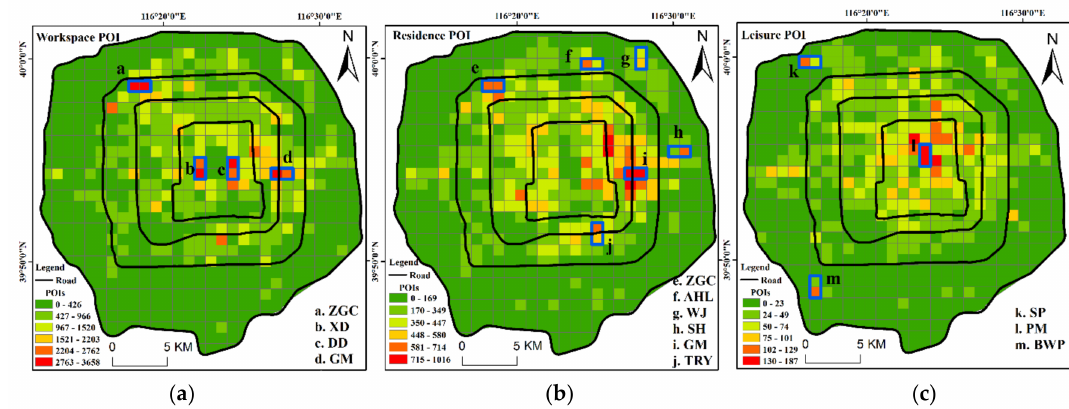
Figure 6. The spatial distribution of functional regions according to spatial semantics based on POI point density: ( a ) Workspace POI; ( b ) Residence POI; and ( c ) Leisure POI represent the functional regions for H 1 (Workplace POI), H 2 (Residence POI) and H 3 (Leisure POI),